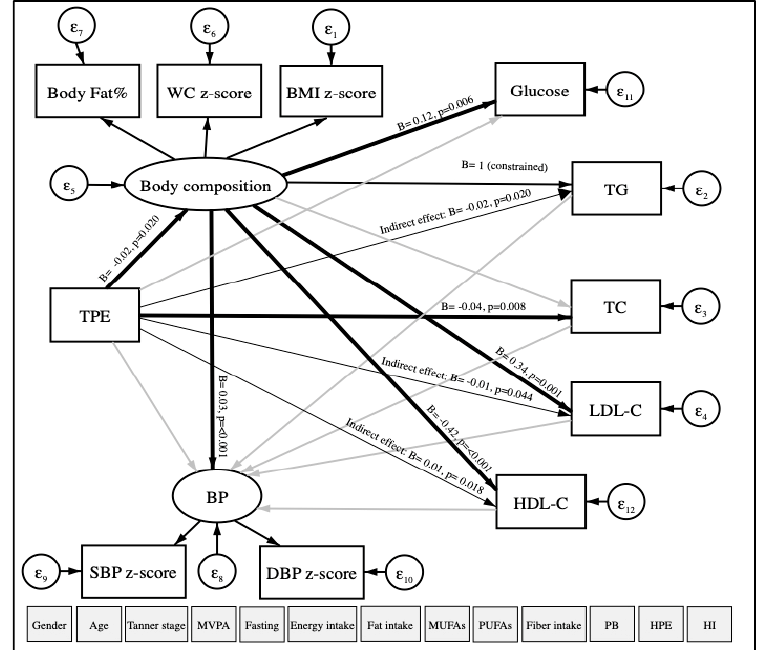
Figure 2. Path diagram of the association between TPE and CVRFs using structural equation modeling. TPE: Total polyphenol excretion in urine. CVRFs: Cardiovascular risk factors. WC: Waist circumference. BMI: Body mass index. BP: Blood pressure. SBP: Systolic blood pressure. DBP: Diastolic blood pressure. TG: Triglycerides. TC: Total cholesterol. LDL-C: Low-density